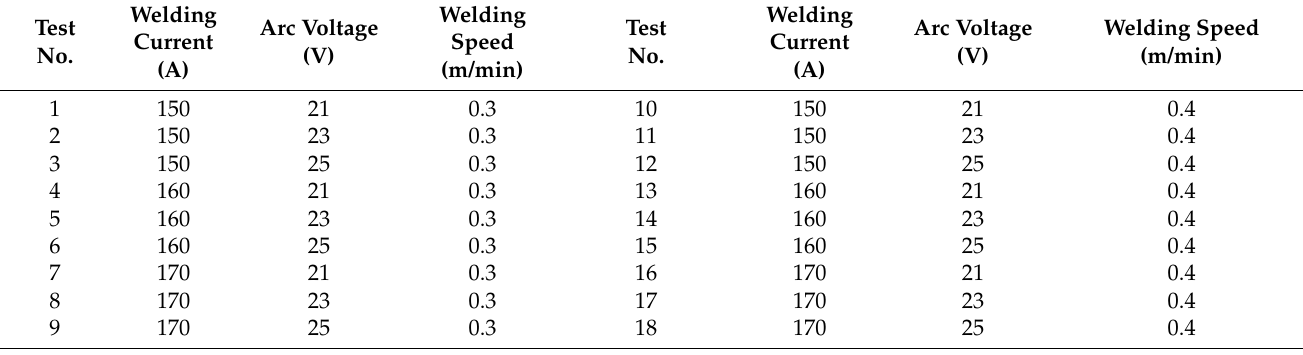
Figure 3. Schematic diagram of weldment geometry. Table 3. FCAW parameters and experimental conditions.